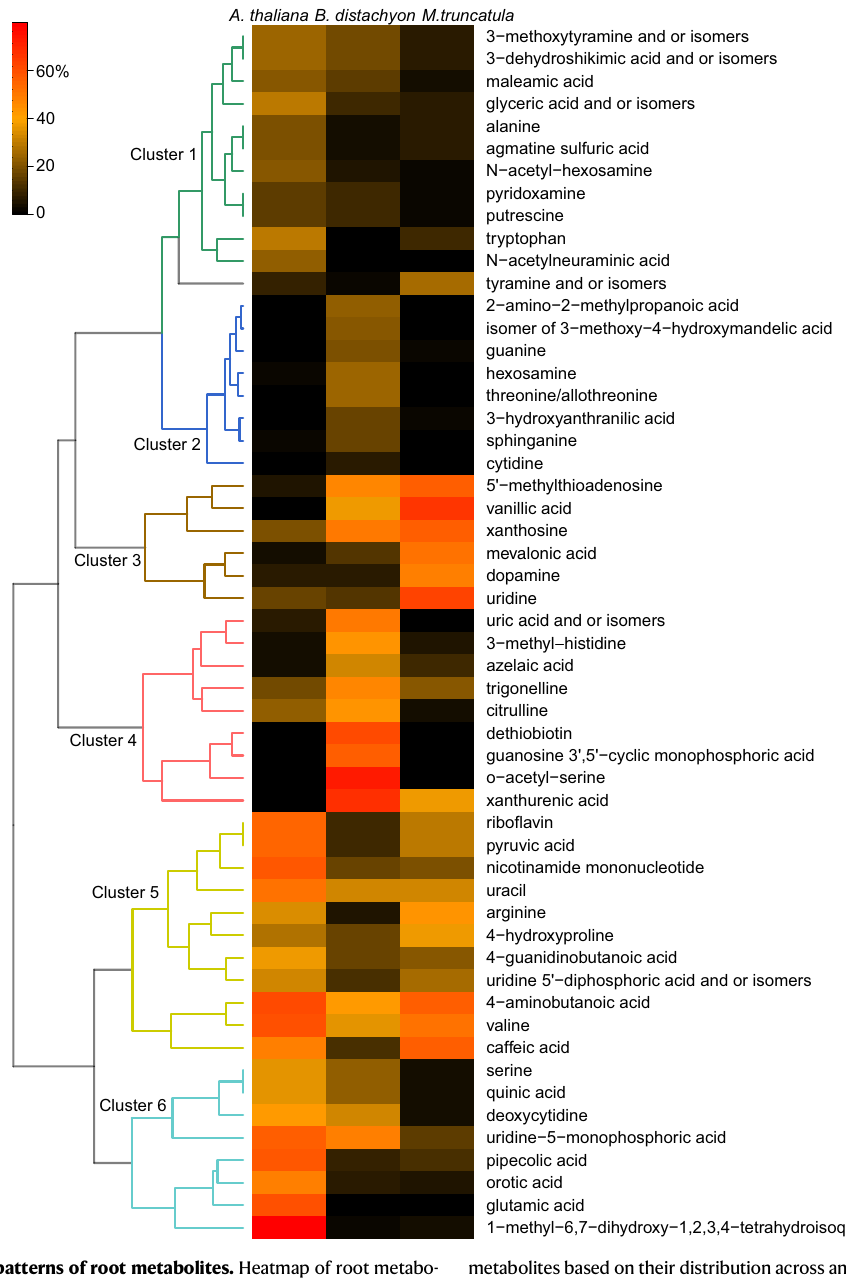
metabolitesbased on their distributionacrossanalyzedspecies. Heatmap of shoot metabolites is found in Supplementary Fig. 6, and PCA plots of tissues in Supple- mentary Fig.